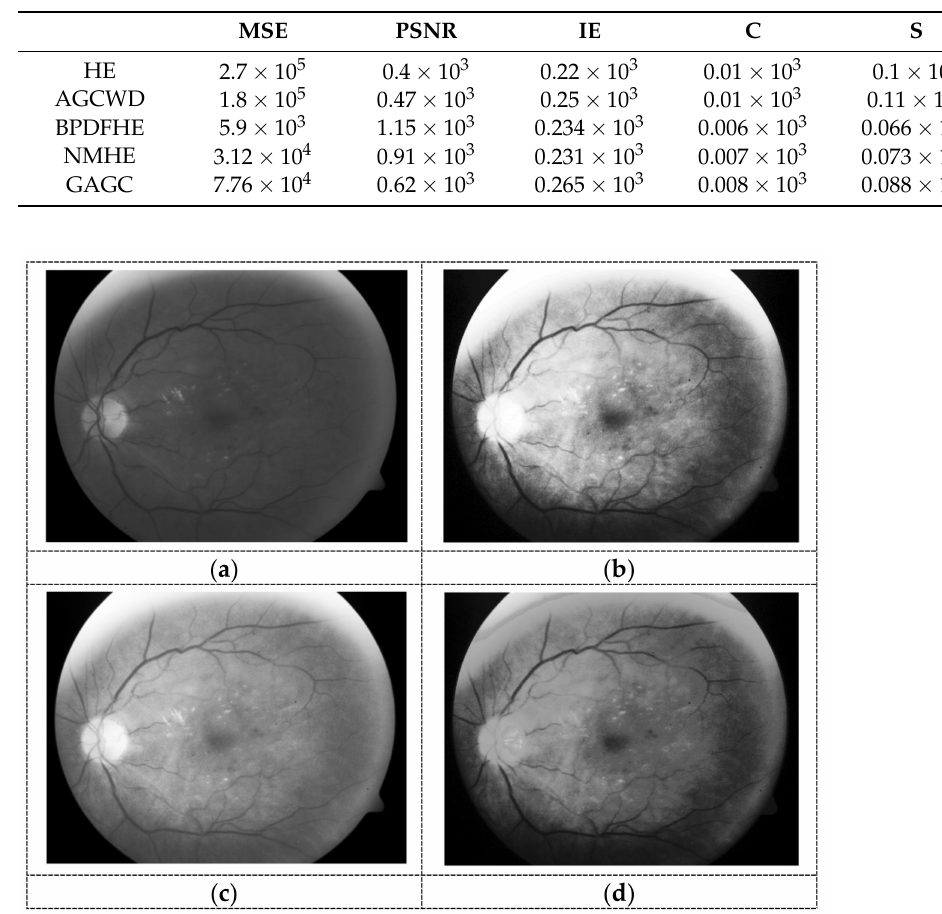
Table 3. Results of the state-of-the-art contrast adjustment techniques.